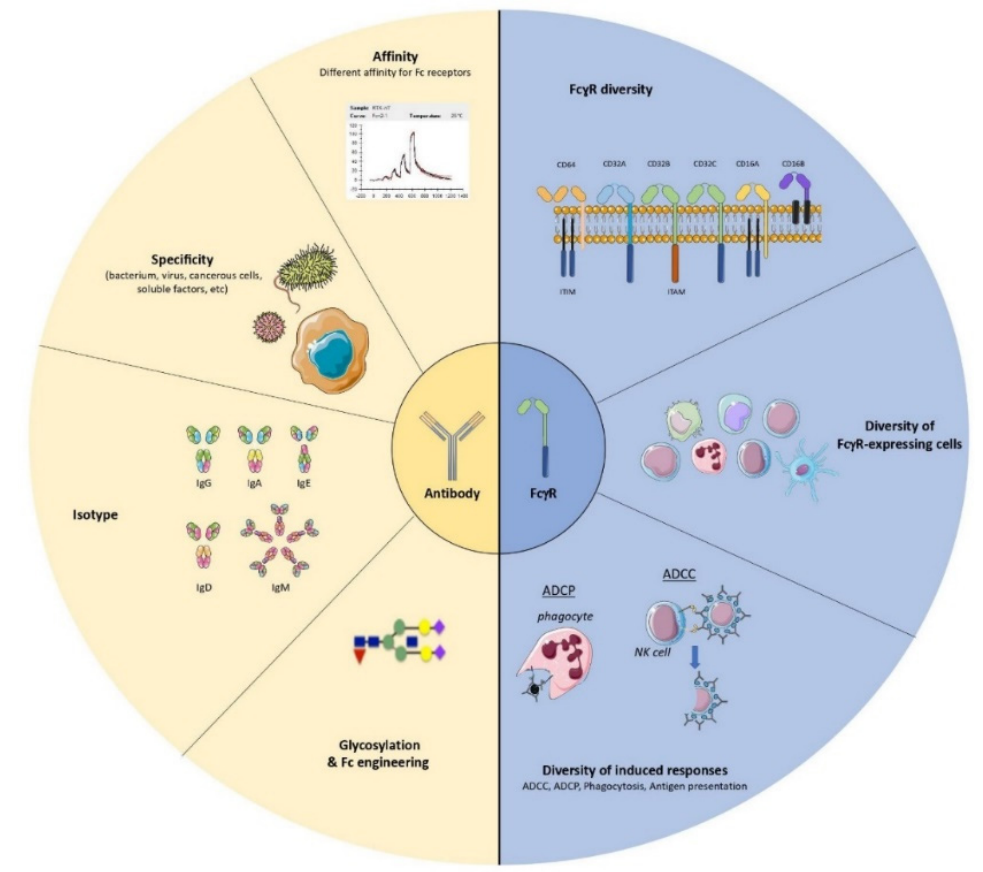
Figure 1. Fc-Fc γ R interactions constitute a very versatile system to modulate immune responses. The different properties of antibodies (affinity, specificity, isotype, Fc-glyco-engineering, etc.) in addition to the complexity of Fc γ Rs biology (multiple Fc γ Rs, different antibody expression patterns and affinities, multiple Fc γ R-expressing cells with specific functions, etc.) allow a myriad of immune functions capable of controlling viral spread and modulating immune responses.